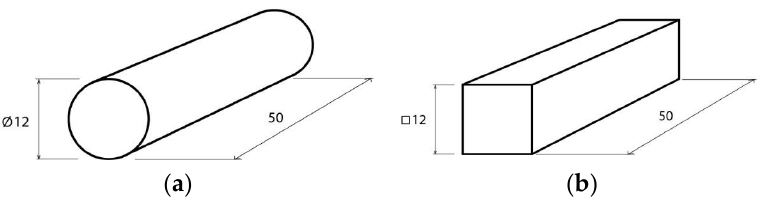
Figure 2. Geometry and dimensions of compression test pieces in millimetres: ( a ) cylindrical test piece and ( b ) prismatic test piece. piece and ( b ) prismatic test